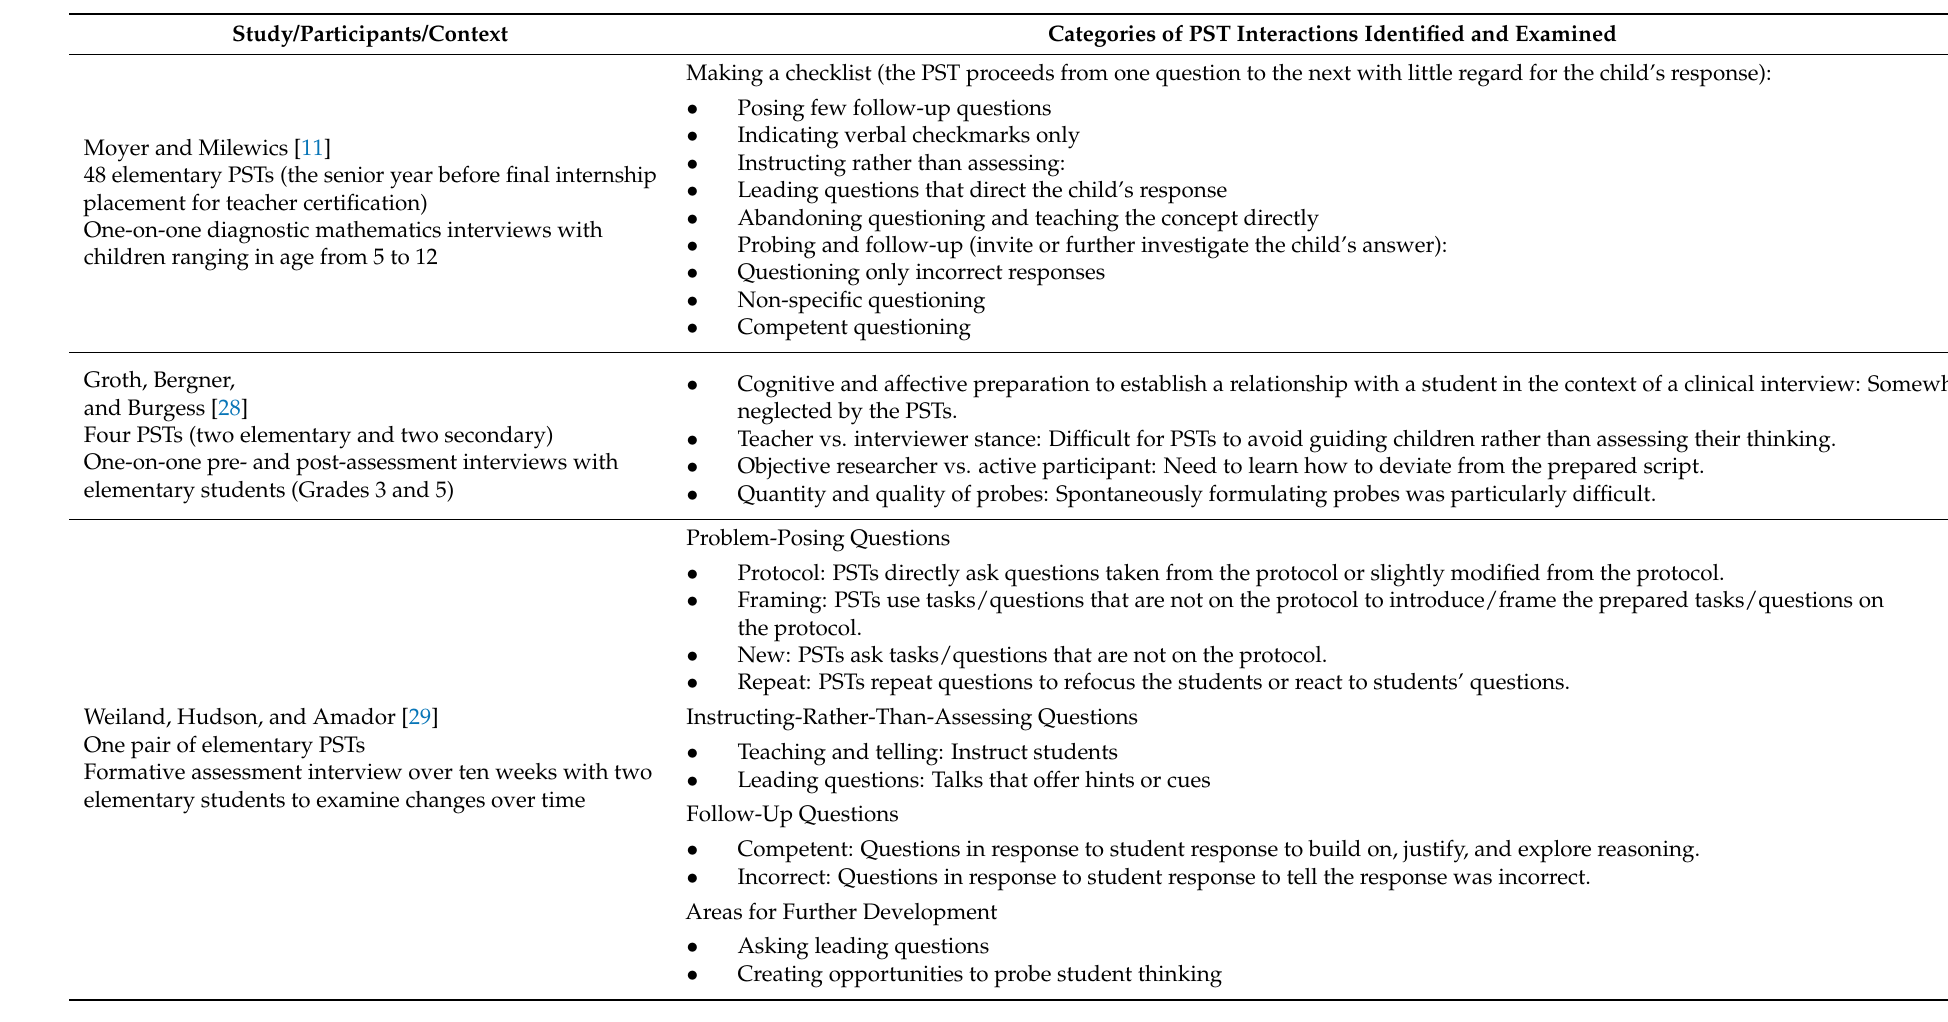
Table 1. Studies on PST performance in eliciting and responding to student